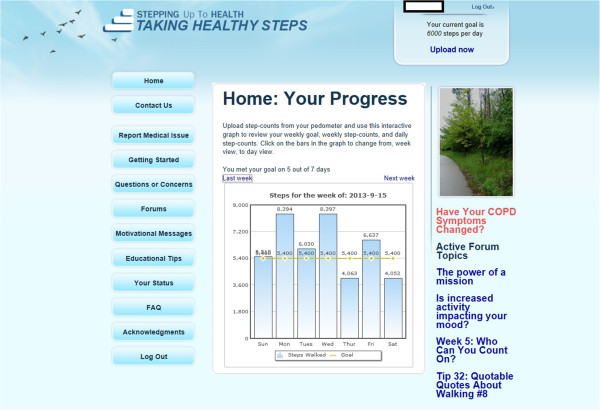
Example of the step-counts screen for participants in Taking Healthy Steps.